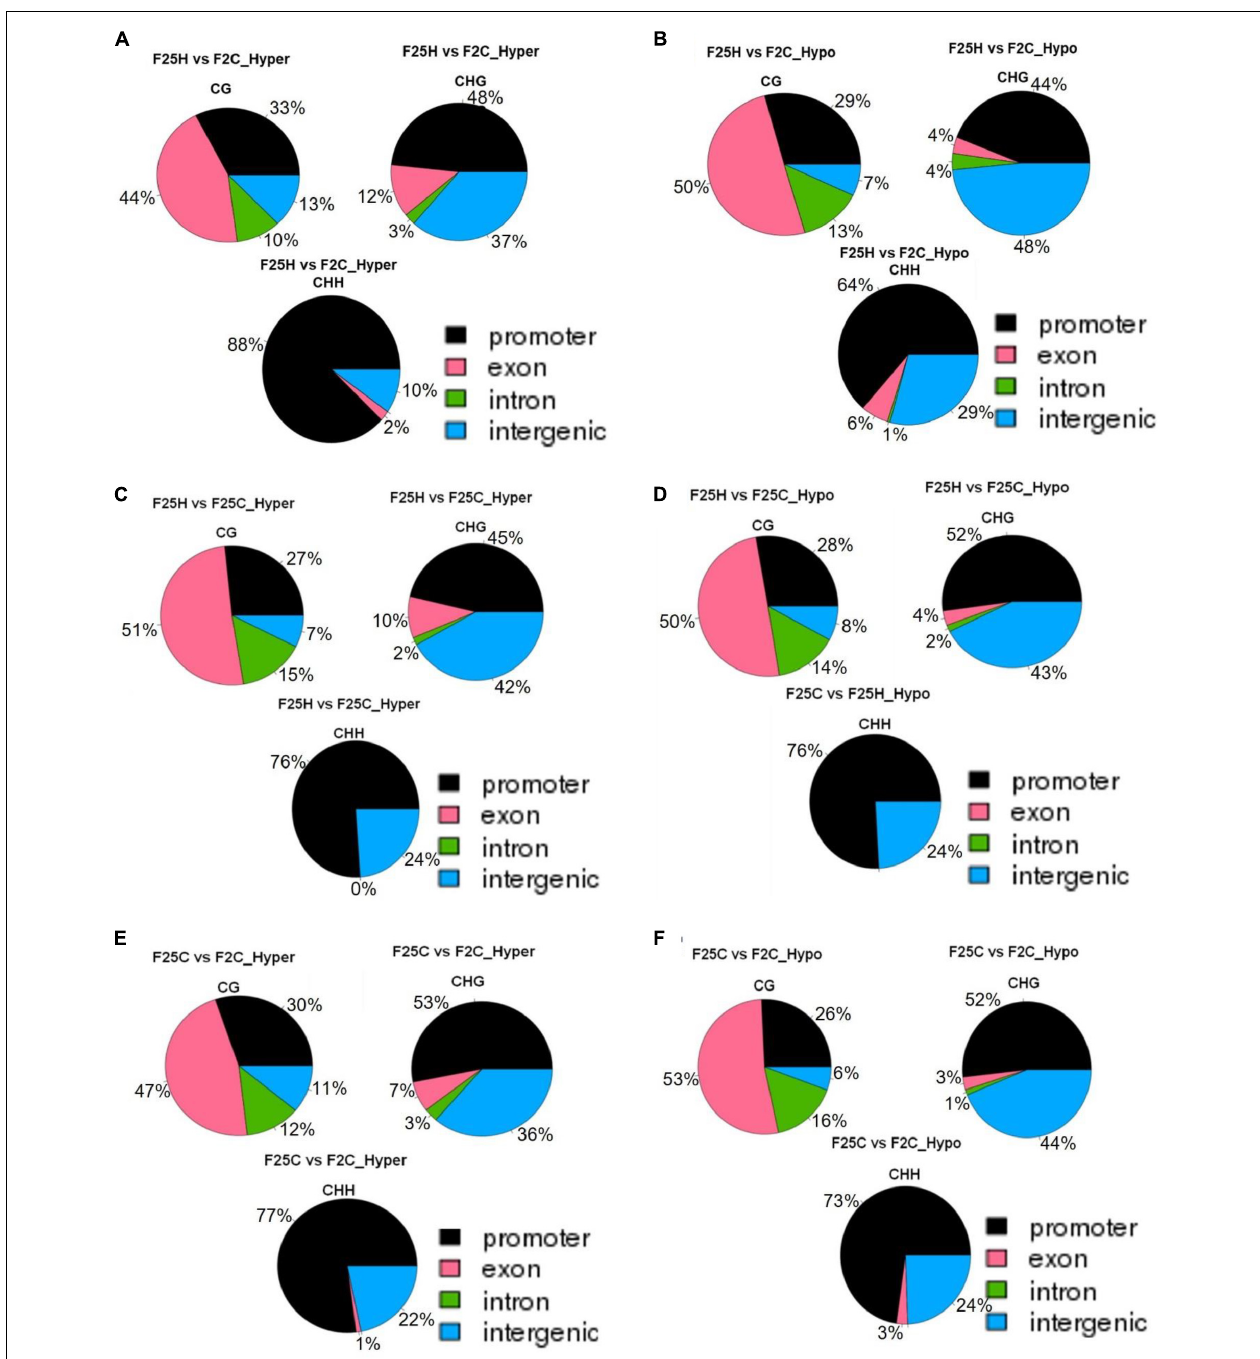
FIGURE 7 | The distribution of hyper-and hypo-methylated DMPs in the genome in the comparison groups F25H vs. F2C ( A – hyper, B – hypo), F25H vs. F25C ( C – hyper, D – hypo) and F25C vs. F2C ( E – hyper, F – hypo). The data are shown as an average percentage of differentially methylated cytosines at the promoter, exon, intron and intergenic regions. DMPs were considered as regions of methylation with > 25% differences.